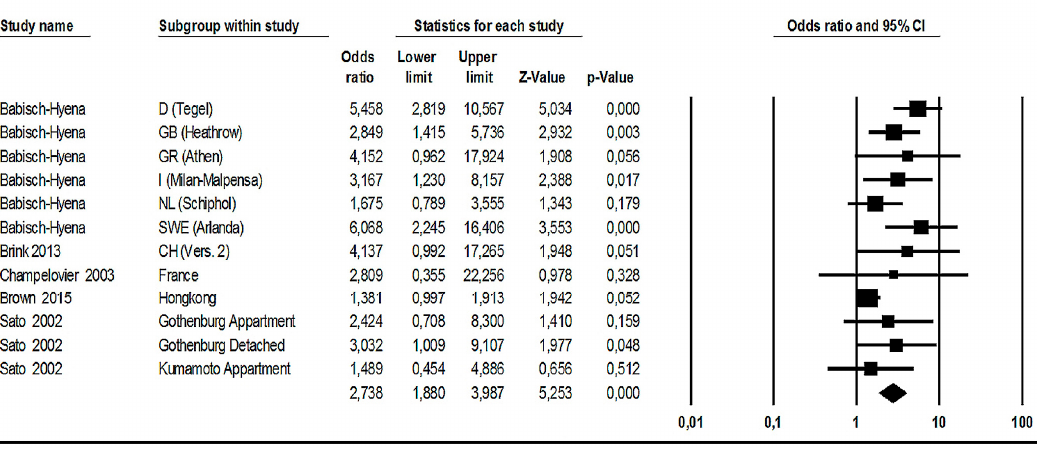
Figure 9. ORs and 95% confidence intervals for the observed “highly annoyed” increase by 10 dB increase (from 50 to 60 dB or 55 to 65 dB L den or L dn ) road traffic noise. The right part of the graph contains a forest plot of the ORs and their respective 95% confidence intervals. The figures of the last row indicate the summary estimates.